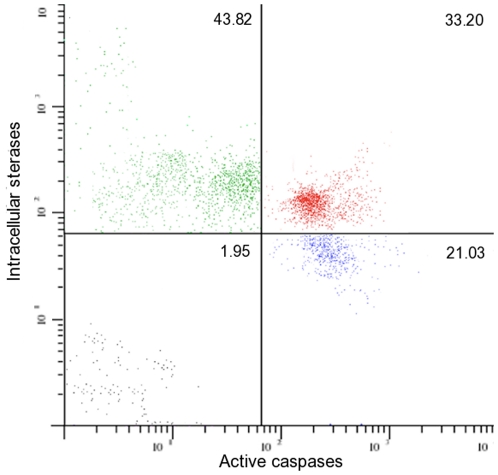
Flow cytometry dotplot showing sperm subpopulations of an ejaculate.Upper left quadrant, sperm expressing intracellular esterases and negatives to active caspases. Upper right quadrant, sperm coexpressing intracellular esterases and active caspases. Lower right quadrant, sperm expressing active caspases and without intracellular esterases. Lower left quadrant, sperm without intracellular esterases nor active caspases. Numbers inside quadrants indicate percentage for each sperm subpopulation.